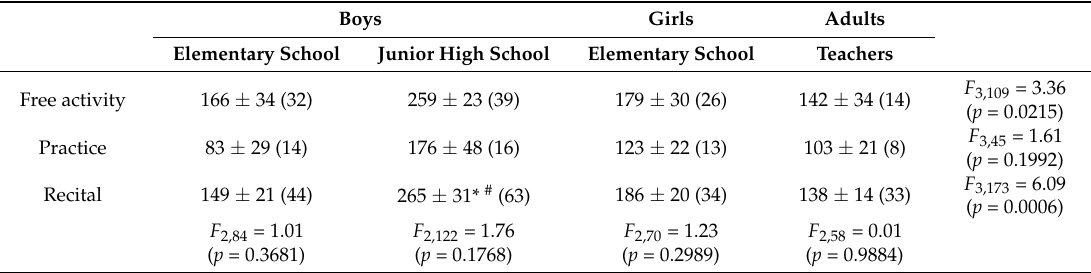
Table 2. Baseline concentrations of oxytocin (pg/mL).